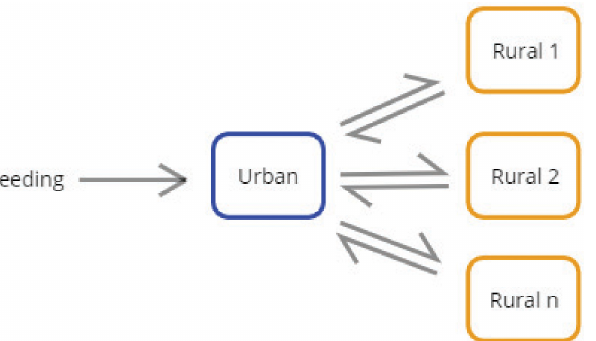
Fig 1. Model schematic showing sample node and migration. Infected individuals were seeded in the urban node and infection spread to rural nodes via urban-rural migration.